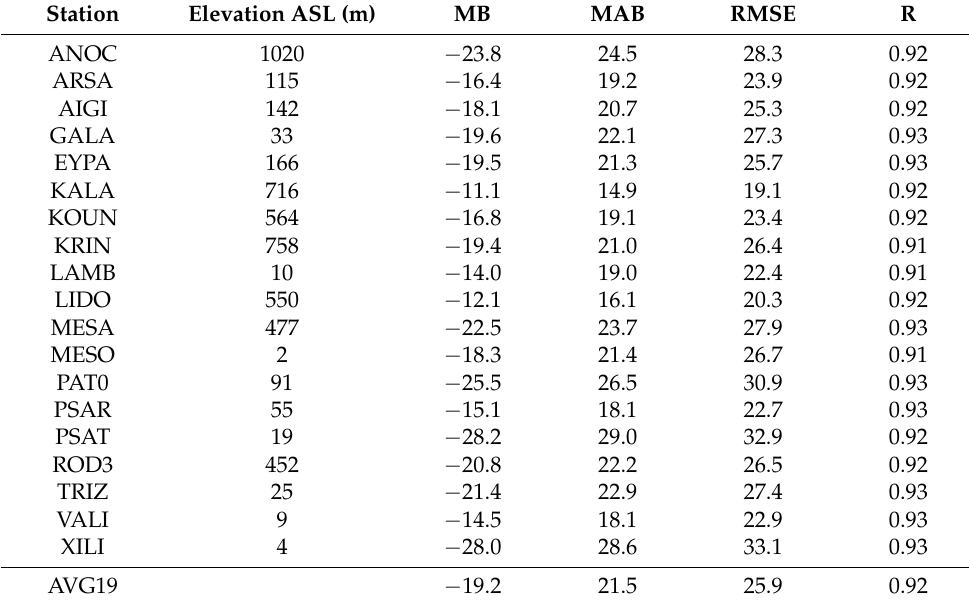
Table 4. Statistical indices of complete WRF ZTS vs. GNSS ZTD time series—January–December